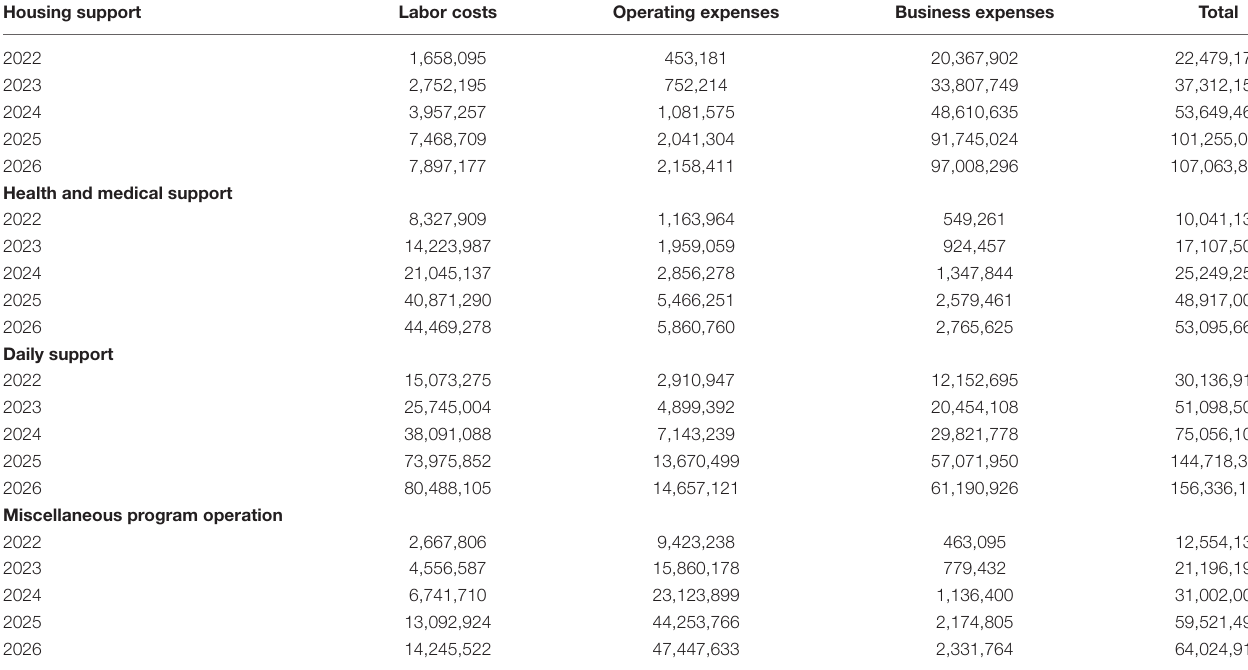
TABLE 8 | Estimated budget for each program type and item for the integrated care for the elderly in the local community.